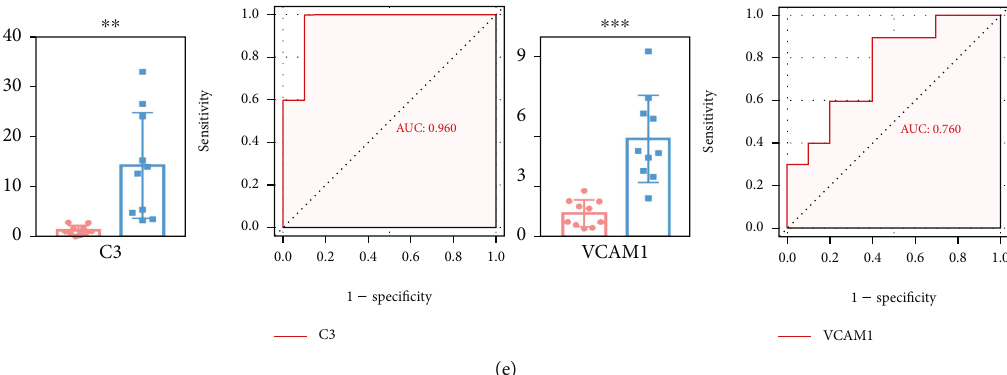
Figure 14: Analysis and validation of the di ff erentially expressed hub IRGs in four databases. (a) GSE7305 dataset. (b) GSE7307 dataset. (c) Validation in the GSE23339 dataset. (d) Validation in the publicly accessible ENDOMET Turku Endometriosis Database. (e) The di ff erences in the mRNA expression levels of C3 and VCAM1 by qRT-PCR between the endometriosis tissues and the controls and the ROC analysis. (a, b) C3. (c, d) VCAM1 (Unpaired Student ’ s t test was used to compare two groups. ∗ P < 0 : 05 ; ∗∗ P < 0 : 01 ; ∗∗∗ P < 0 : 001 ; ∗∗∗∗ P < 0 : 0001 ).